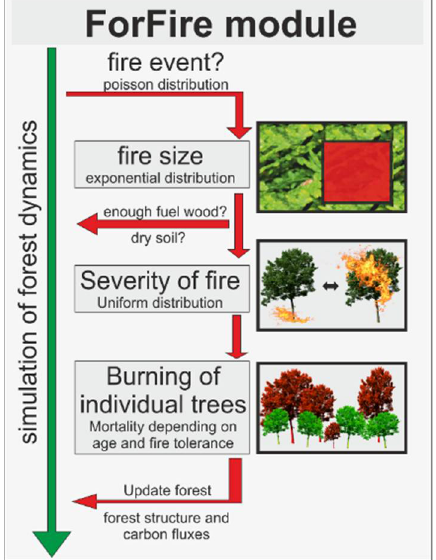
Figure 5. Schematic representation of the fire model ForFire. This fire model was integrated in the forest model FORMIND. In each time step (here: 1 year) the random number of fires in this time step is determined. Then, an exponential distribution is used to specify the size of the forest fire. To ensure that the fire can break out, each sub-area (20 m plot) of the total simulation area is checked for whether there is enough biomass and for whether the top layer of soil is not too wet. After that, the type of fire is determined randomly, either a strong crown fire or a lighter ground fire. However, not all trees in the fire area burn and die. The probability of a tree dying from fire depends on the strength of the fire, the size of the tree, and the fire tolerance depending on the